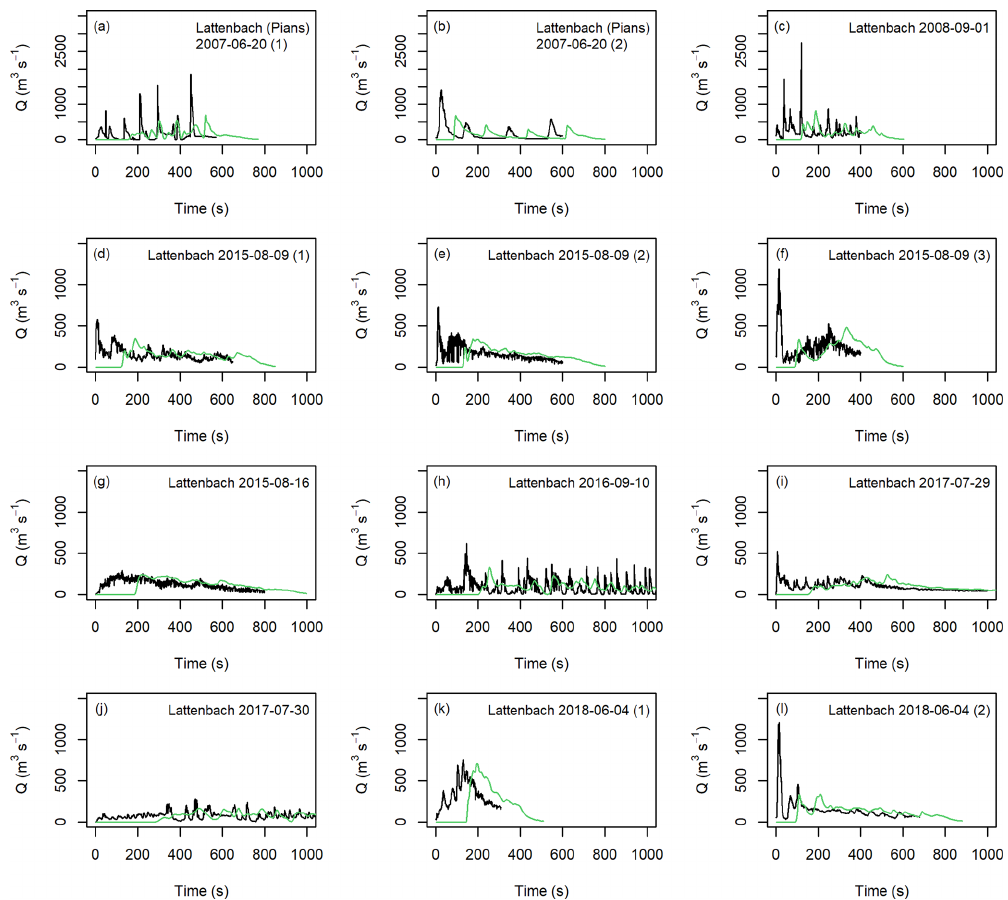
Figure 8. Comparison of input hydrographs (black lines) from the Lattenbach site and extracted hydrographs at x = 1000m in the numerical experiment (green lines). Note the different y -axis range for panels (d) through (l) compared to panels (a) through (c)